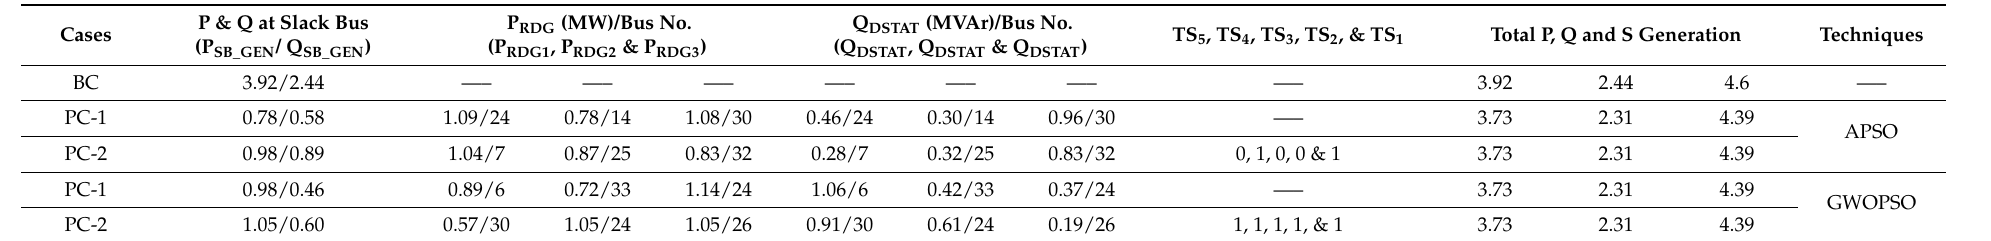
Table 4. Simultaneous optimal planning of DGs (in MW and MVAr) with and without reconfiguration of 33 bus RDN.